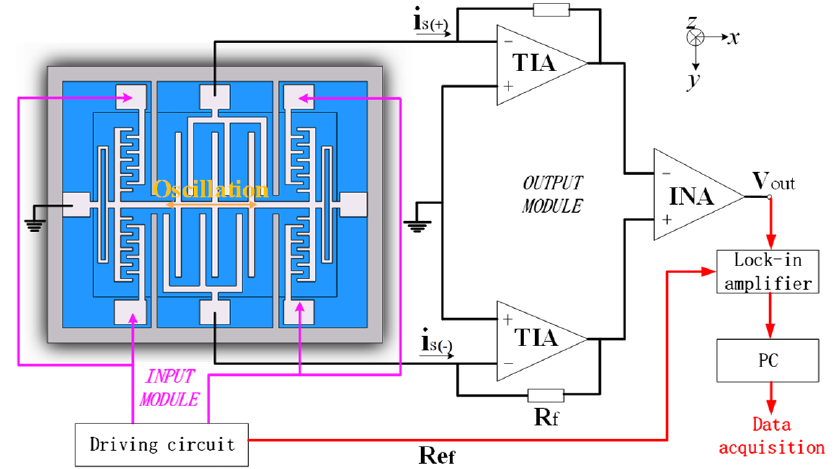
Figure 10. Detection schematic. TIA, transimpedance amplifier; INA, instrumentation amplifier.